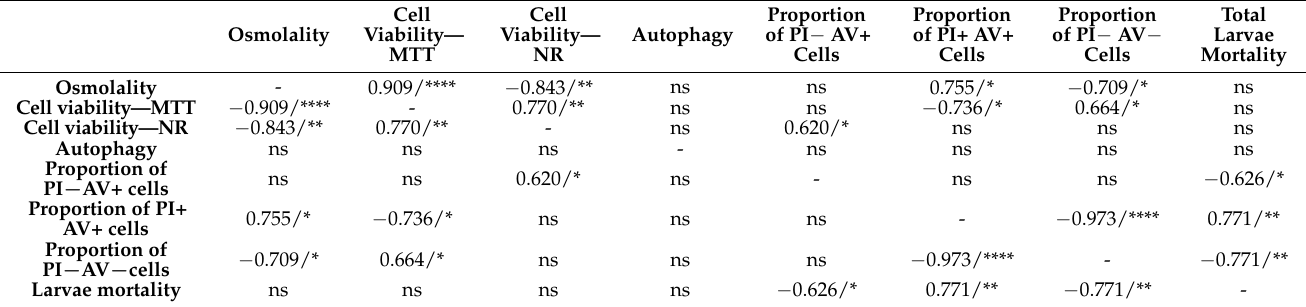
Table 2. Correlation of matrix of all measured data sets (only PEGs). Spearman correlation coefficient and significance levels are shown as: ns = p ≥ 0.05; * = p < 0.05; ** = p < 0.01; and **** = p <